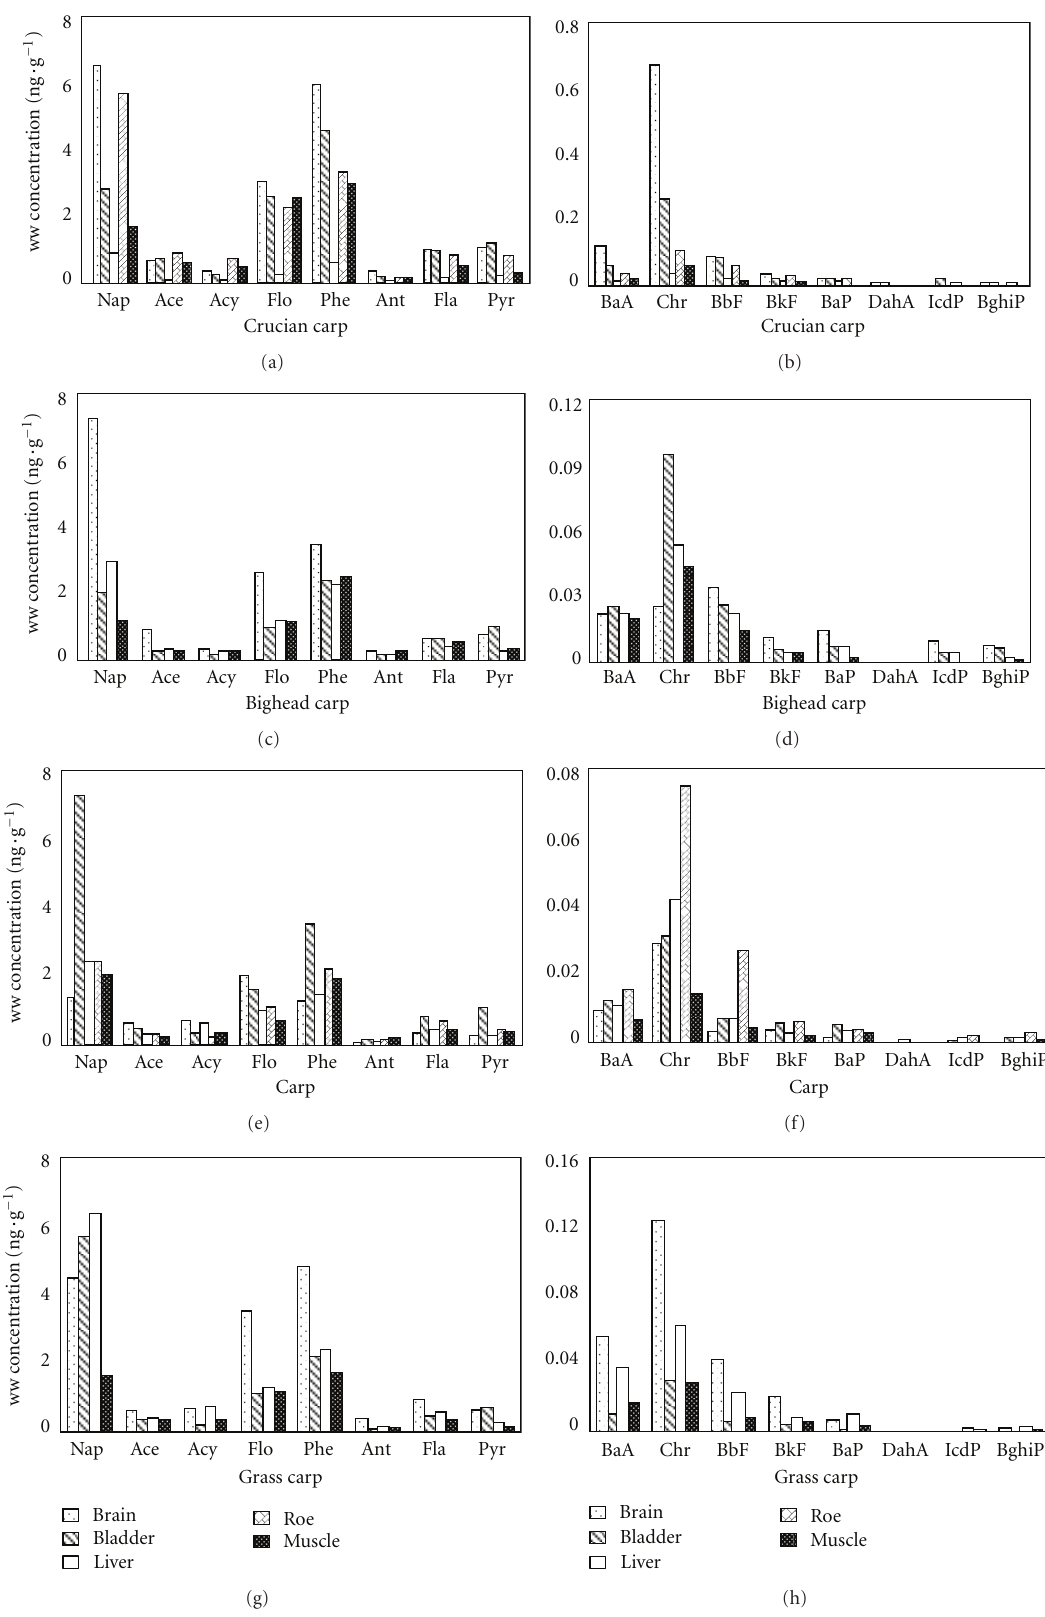
Figure 2: Distribution pattern of PAH congeners in the tissues and organs of four fish